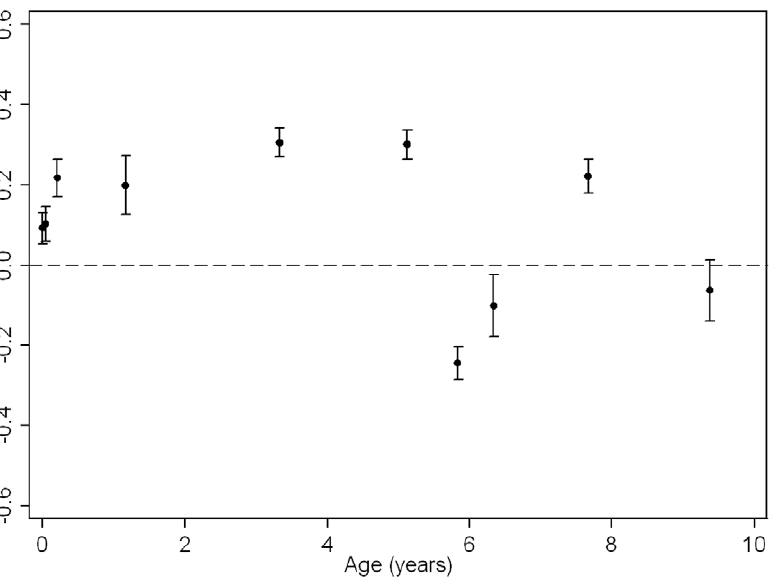
Figure 4. Girls Coefficients and 95% confidence intervals from standardised linear regressions of DXA-assessed fat mass at age 15 on PI/BMI trajectories (age in years along x-axis is the mid-point of PI/BMI change periods; coefficients are adjusted for confounders and previous PI/BMI changes, i.e. Model 3).